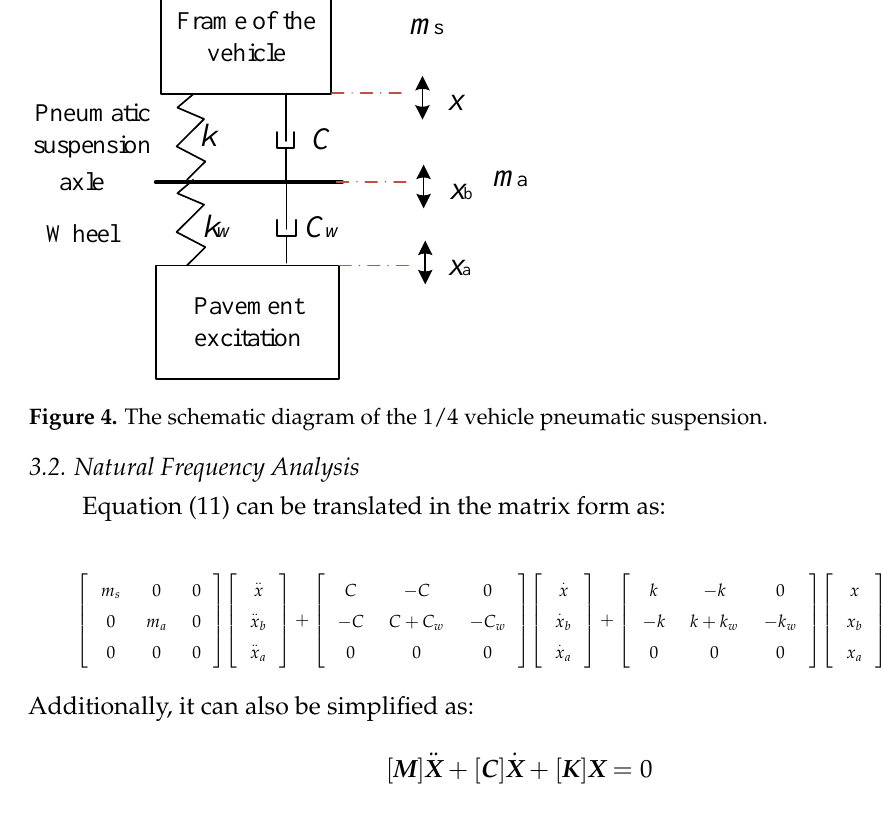
5 of 14 Figure 3. Parameters of the rubber connector. 3. Analysis of the Vehicle Pneumatic Vibration Isolation Model